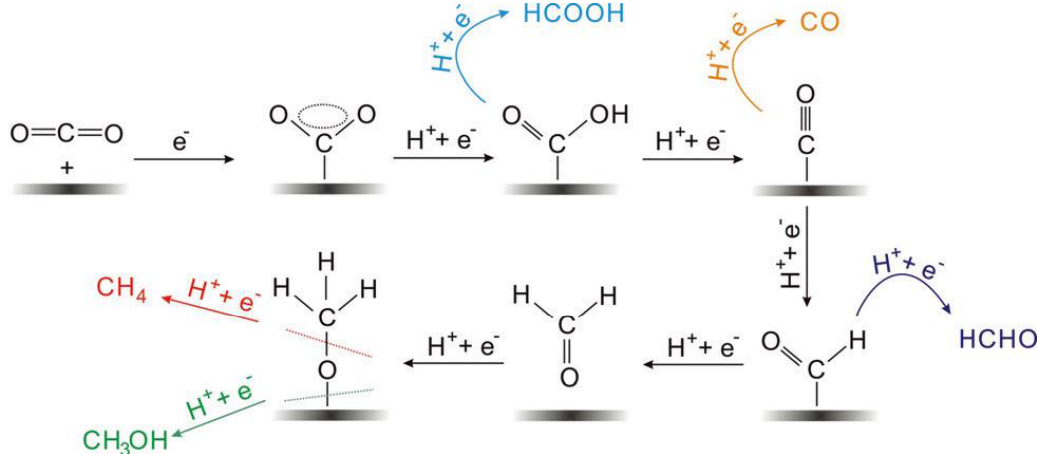
Figure 1. Reaction mechanism of electrochemical CO 2 reduction on electrodes in aqueous solutions and the formation paths for the five main C1 products during the reduction process. Reprinted from Ref. [60], copyright (2017), with permission from Wiley.